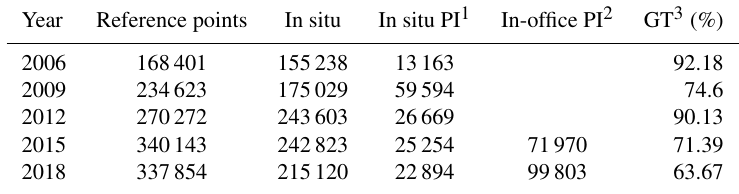
Table 4. Number and recording method of reference points in the LUCAS land cover and use database per time